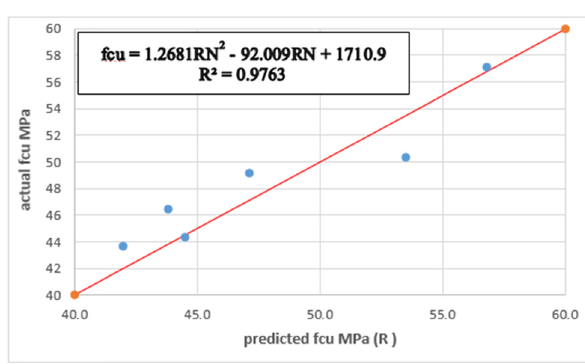
Figure 12: Rebound number and compressive strength relationship for concrete with fi ber content from 0 to